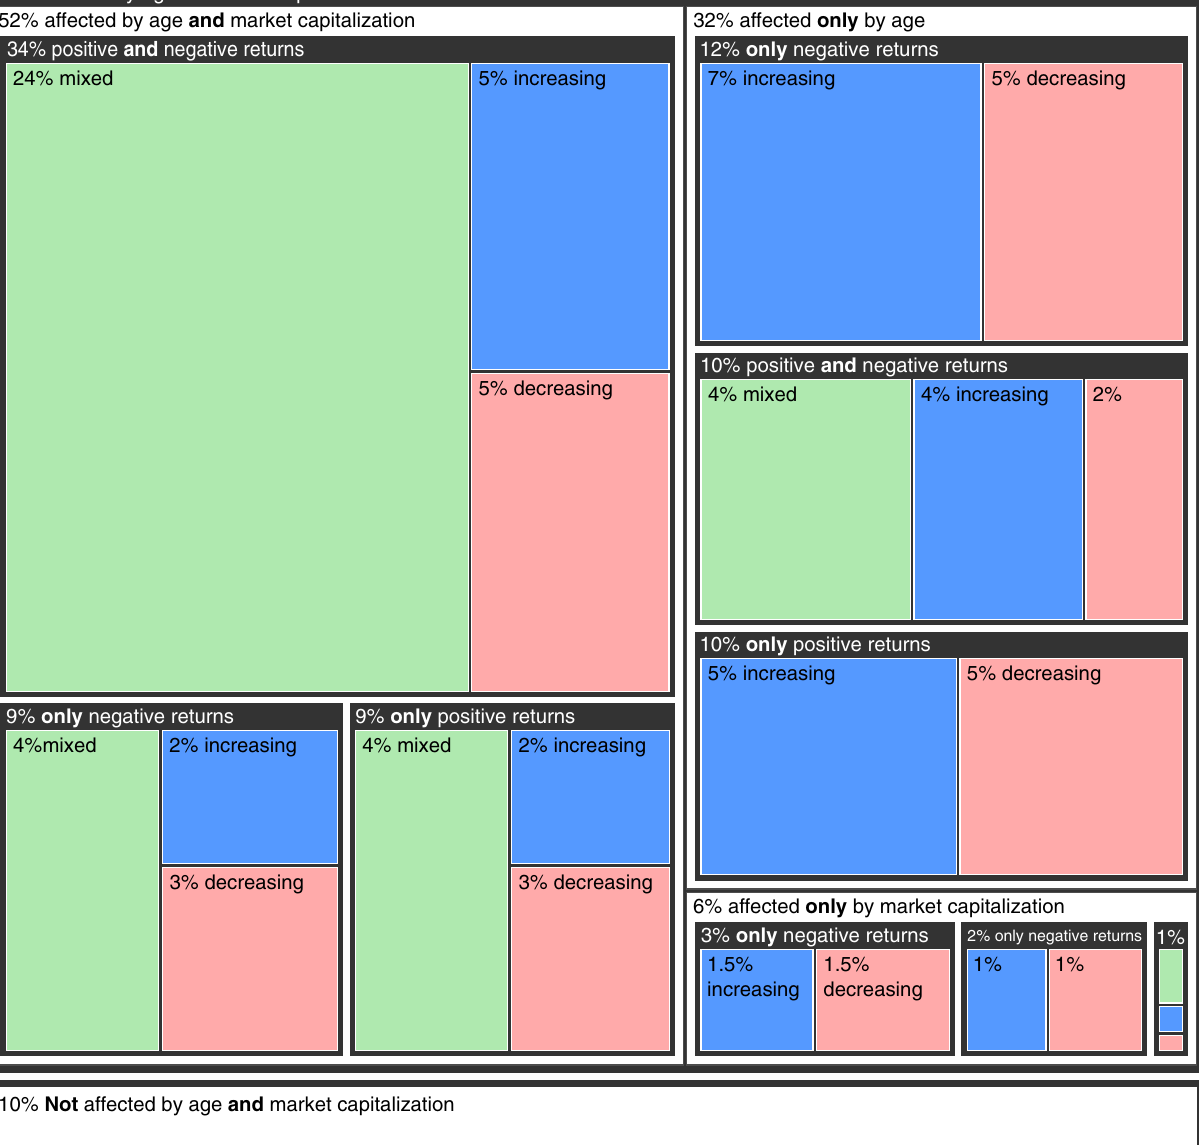
Figure 4. Summary of the effects of age and market capitalization on power-law exponents of the cryptocurrency market. Hierarchical visualization or a tree map of the possible effects of age and market capitalization on the power-law exponents. The first level (two outermost rectangles) separates cryptocurrencies that are affected by age or market capitalization (90%) from those unaffected by any of these quantities (10%). Cryptocurrencies affected by age or market capitalization are classified as those simultaneously affected by both quantities (52%), those affected only by age (32%), and those affected only by market capitalization (6%). Each of the previous three levels is further classified regarding whether both positive and negative returns are simultaneously affected or whether the effect involves only positive or only negative returns. Finally, the former levels are classified regarding whether the power-law exponents increase, decrease or have a mixed trend with the predictive variables. Overall, 36% of the associations are classified as mixed trends (green rectangles), 28% are increasing trends (blue rectangles), and 26% are decreasing trends (red